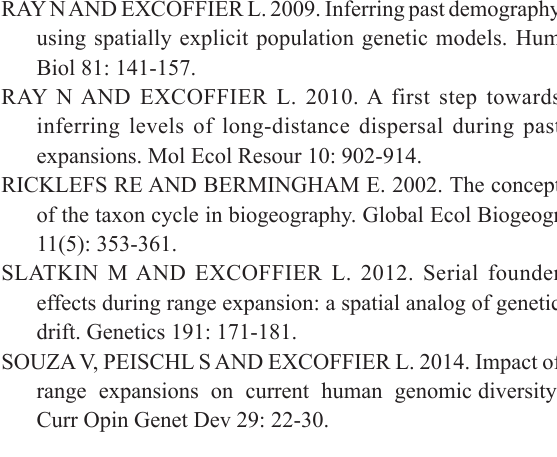
Fig. S1 - Spatial genetic sectors formed during demographic expansions through time to populations with individuals with different dispersal capacities (G = 1, G = 5, G = 10) and under different scenarios of habitat restoration. The center of each circle represents the time = 0, and the border, time = 1500. The average Z-value of 10 replicas (allelic fixation index) of each time interval (corresponding to 10 time steps) of each sector